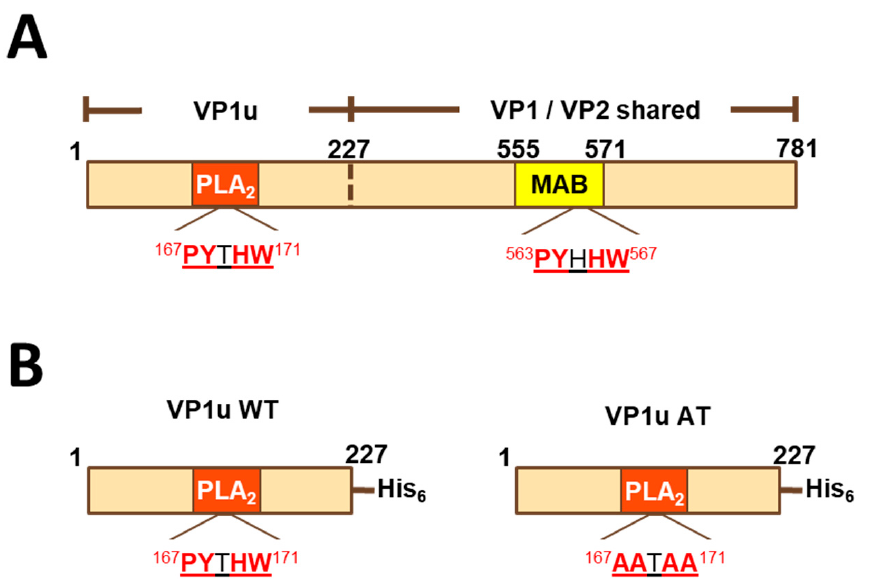
Figure 1. Linear diagrams of VP1 and its fragments. ( A ) Full-length VP1 sequence. VP1 and VP2 differ in that VP1 has an N-terminal extension (VP1u). Additionally, the sequence similarity of a 5-residue motif found in VP1u and VP2 is shown. ( B ) Histidine-tagged peptides VP1uWT and VP1uAT. MAB-MAB8293 epitope (residues 555–571 of VP1); PLA 2 -phospholipase A 2 -like domain; VP1u-VP1 unique region.